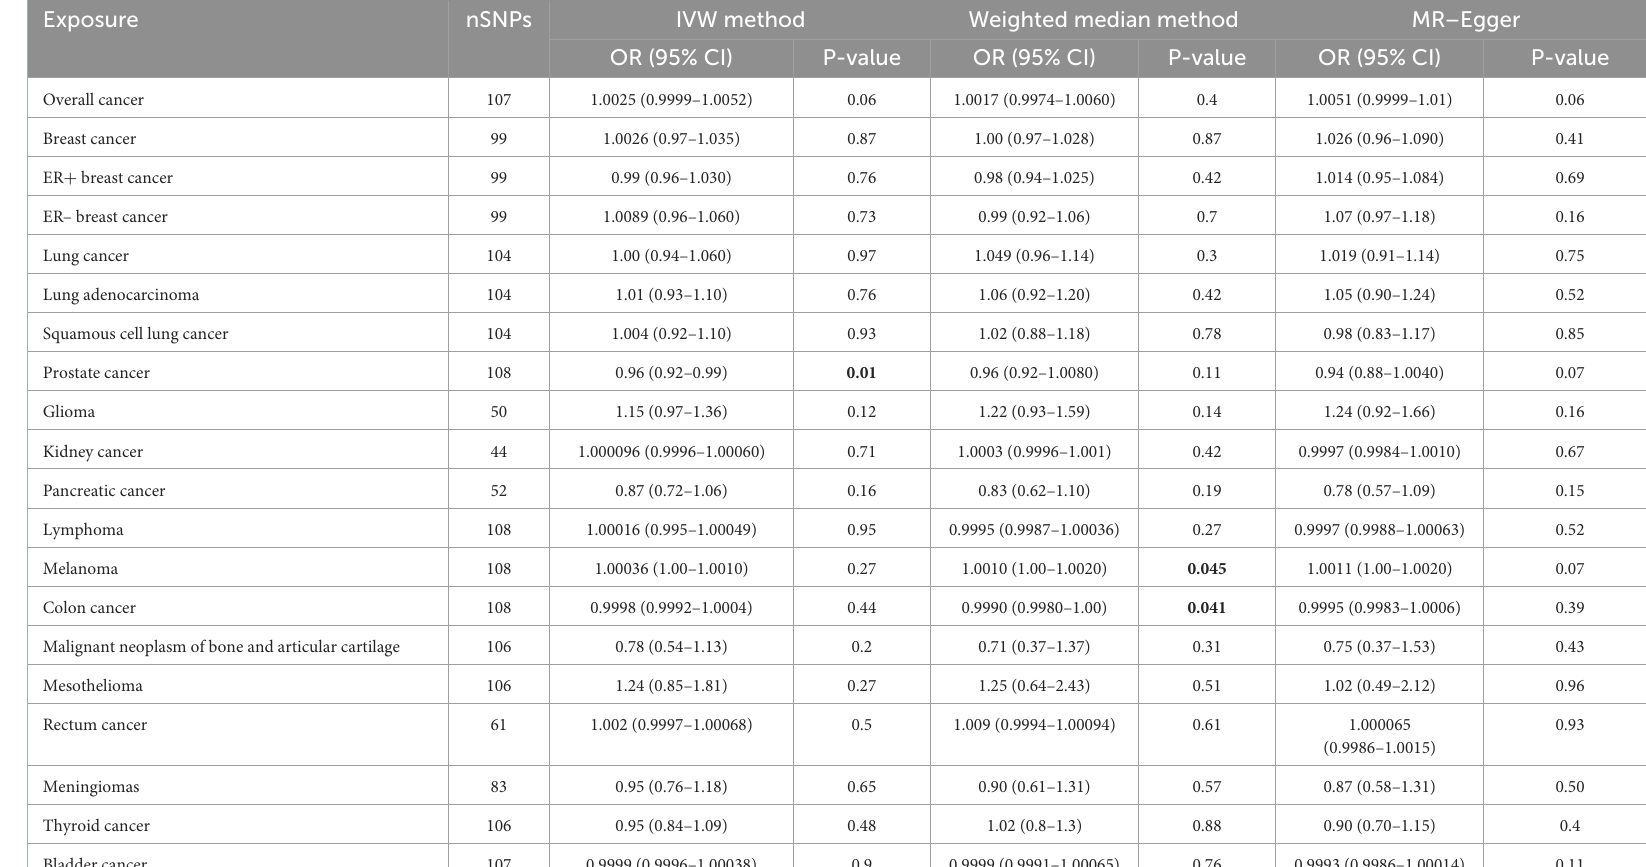
TABLE 2 Mendelian randomization estimates of the casual relationships between atrial fibrillation and cancer risks. Exposure